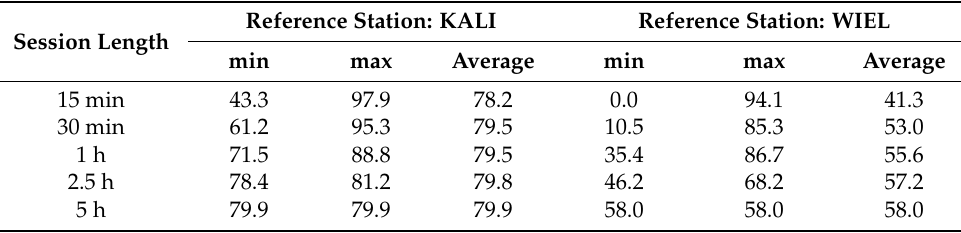
Table 2. Statistics of fixed ambiguities [%] in the relative mode for point S1. Session